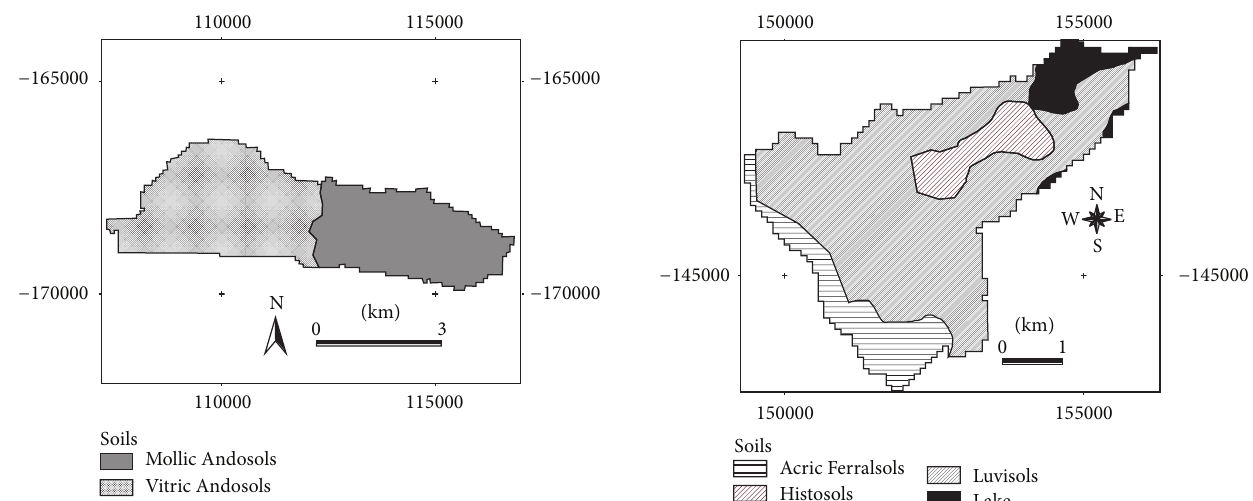
Figure 4: Soils of Gataraga microcatchment (2009). Figure 5: Soils of Bufundi microcatchment